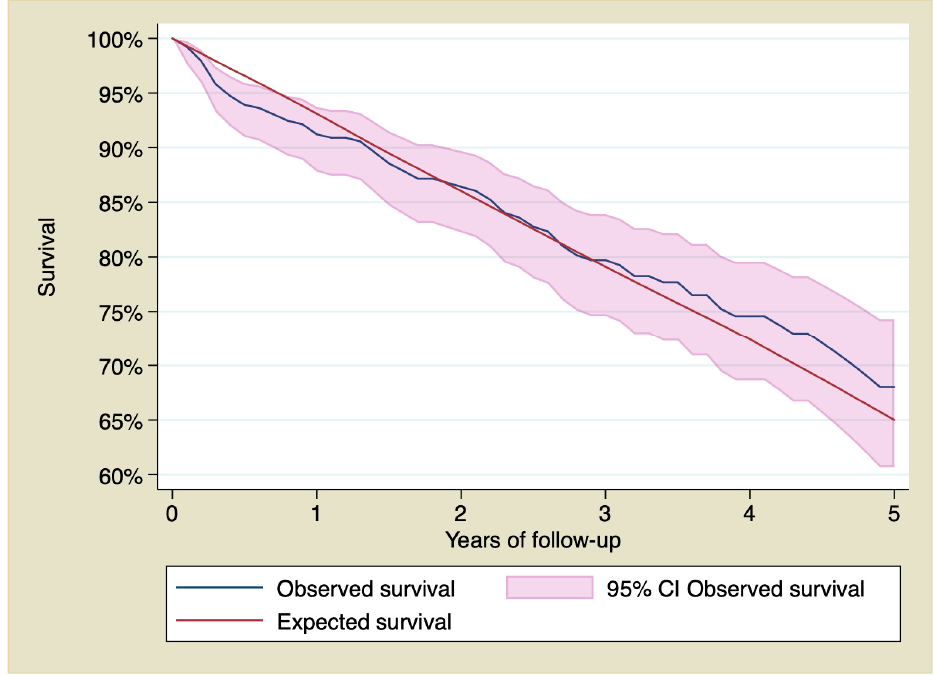
Figure 4. 95% confidence interval of the observed survival compared with the expected survival. Only patients who survived the first 30 days after the ST elevation myocardial infarction.